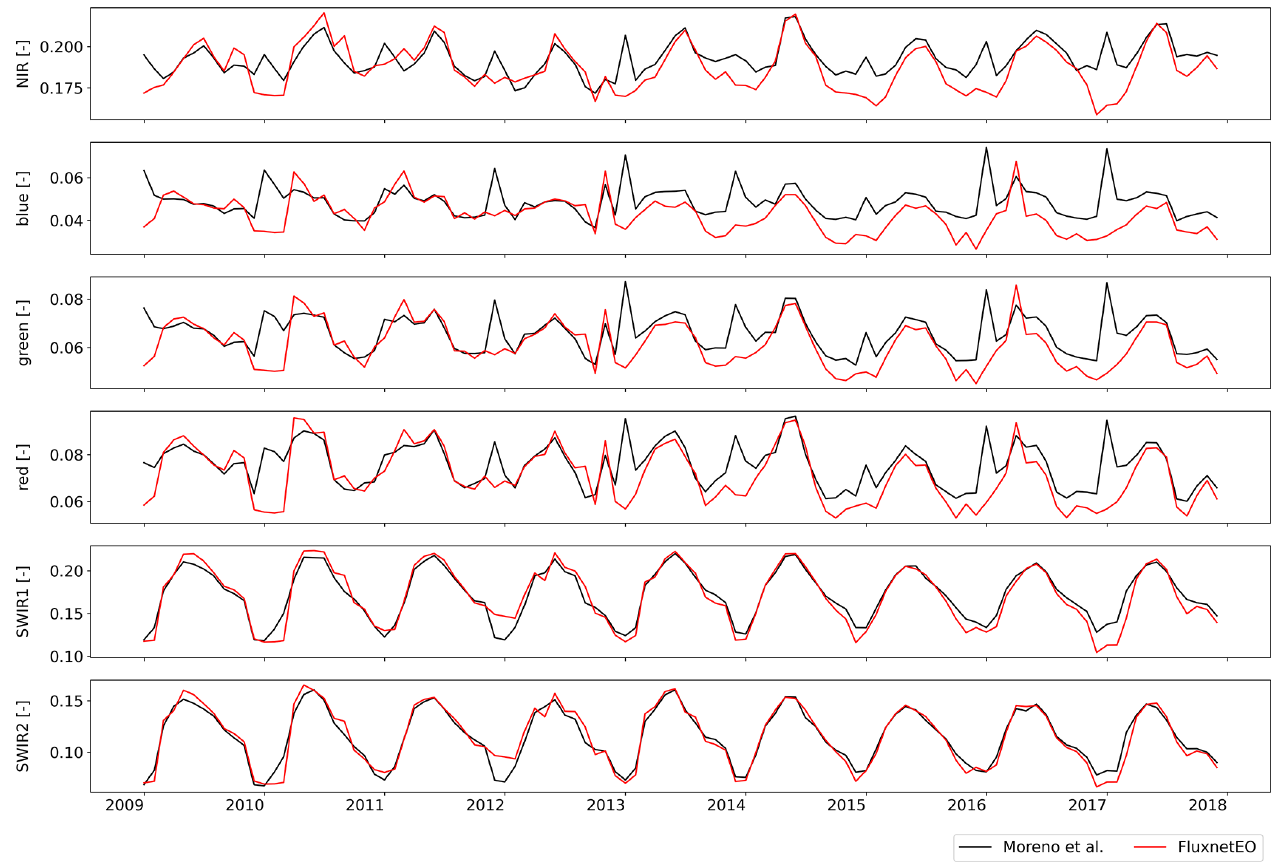
Figure C8. Example site US-Fmf: comparing the gap-filled surface reflectance products in spectral